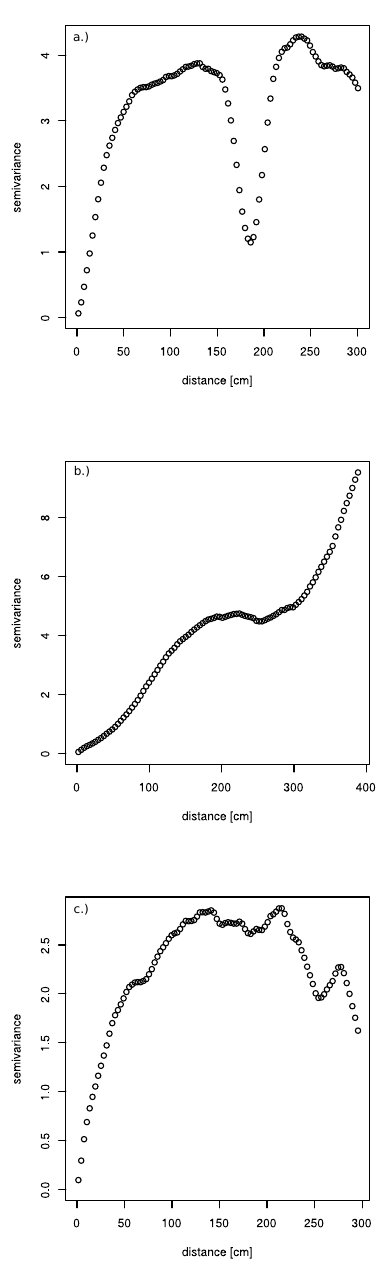
Figure 3: Sample variograms of the roughness plots from Fig 2 showing a.) a significant two scale roughness pattern (R12), b.) a spatial trend (R14) and c.) no spatial trend with an insignificant two scale roughness pattern (R21)